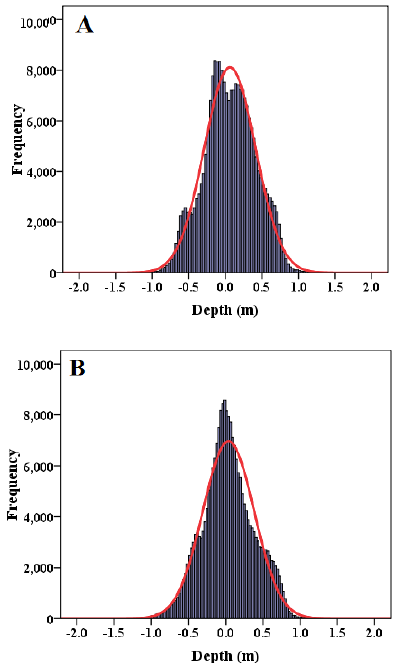
Figure. 5. Histogram of depth difference between known depth and bands 1, 3 and 4 in linear relation (A); Histogram of depth difference between known depth and the same bands in exponential relation (B). The red curve in both figures represent normal distribution.